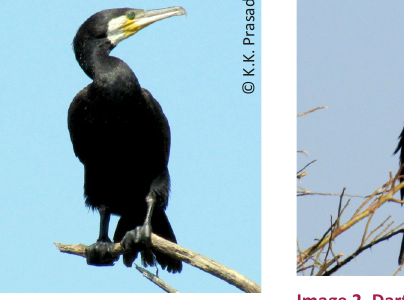
Image 2. Darter Anhinga melanogaster